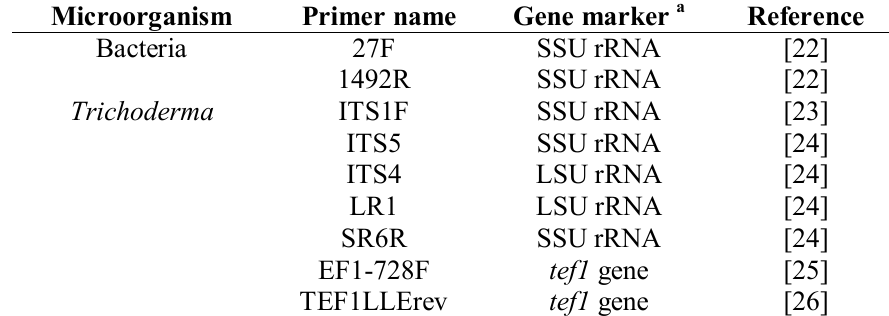
Table 3. Primers used in this work for the identification of microbial isolates; the same primers were used for amplification and